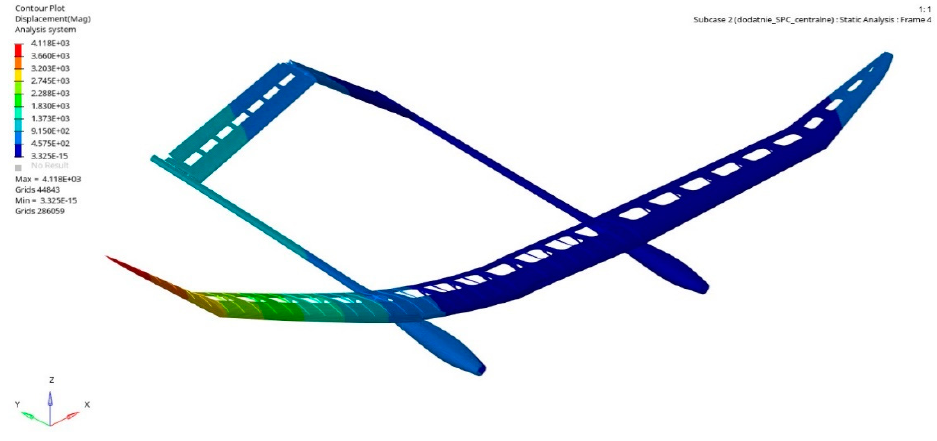
Figure 18. Global displacement plot.